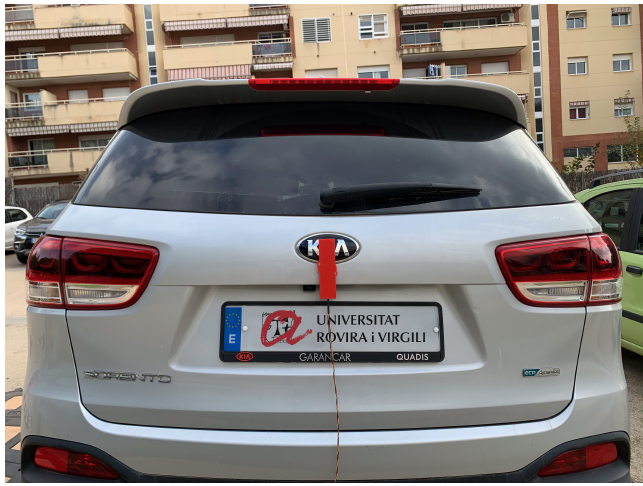
Figure 9. Photography of a car with the transponder installed on the